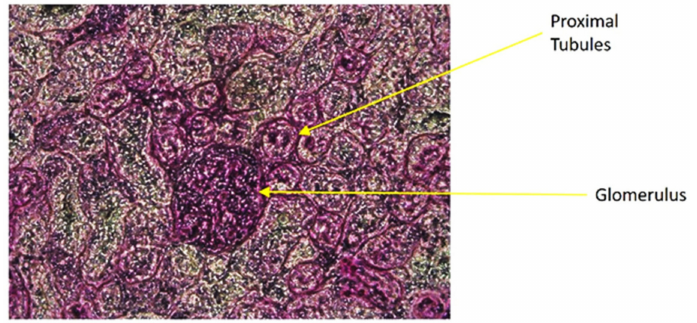
Figure 9. Periodic acid-Schiff (PAS) staining of kidney cortex sections.